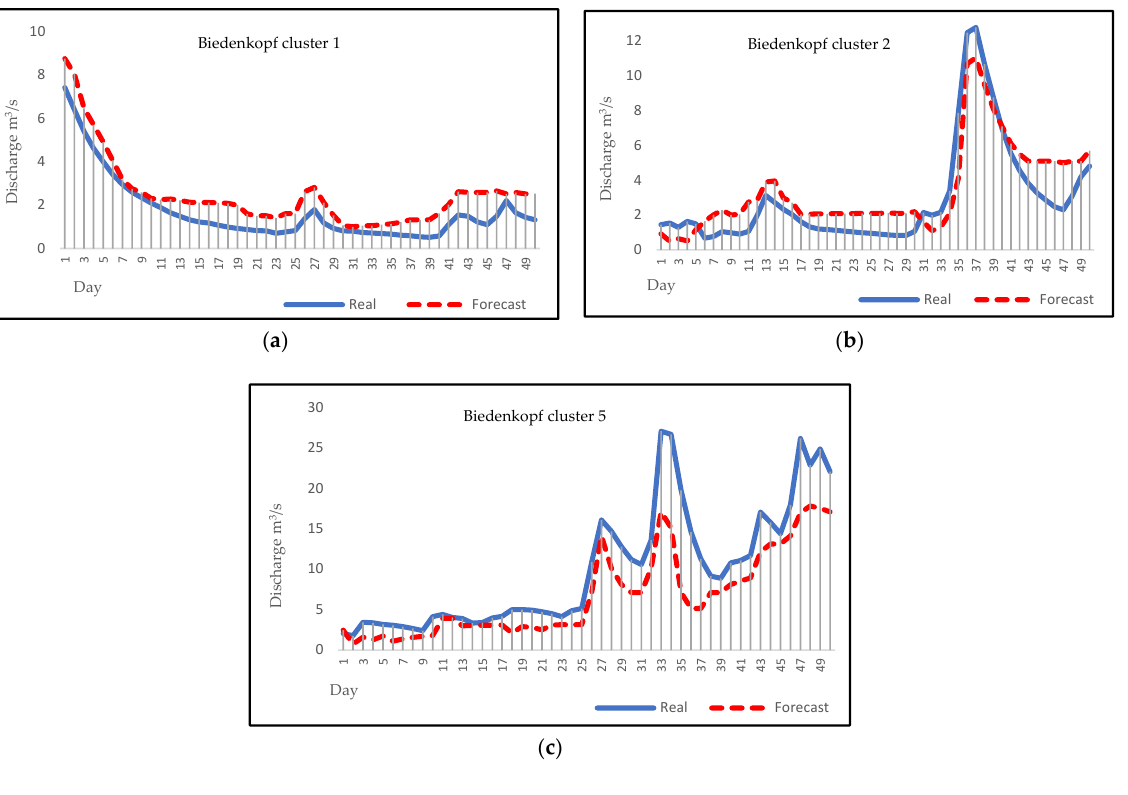
Figure 5. ( a ) Forecasting plot for Biedenkopf cluster 1; ( b ) forecasting plot for Biedenkopf cluster 2; ( c ) forecasting plot for Biedenkopf cluster 5.